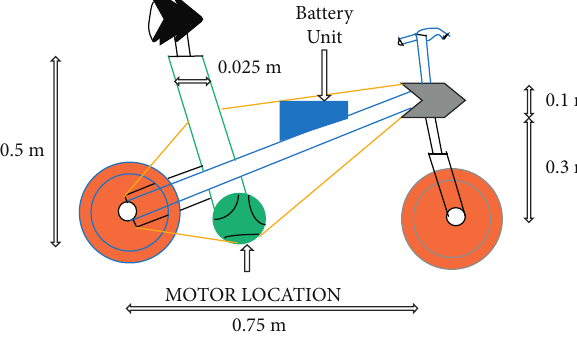
Figure 8: Chain sprocket with teeth.